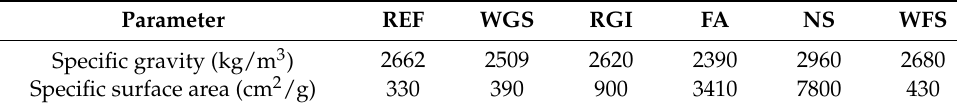
Figure 3. Particle size distribution of the fillers determined by Mastersizer 2000 laser diffraction particle size analyser (REF—Reference filler, WGS—Waste glass from solar panels, RGI—Waste from the production of mineral insulation boards, FA—Fly ash, NS—Neutralization sludge, WFS—Waste foundry